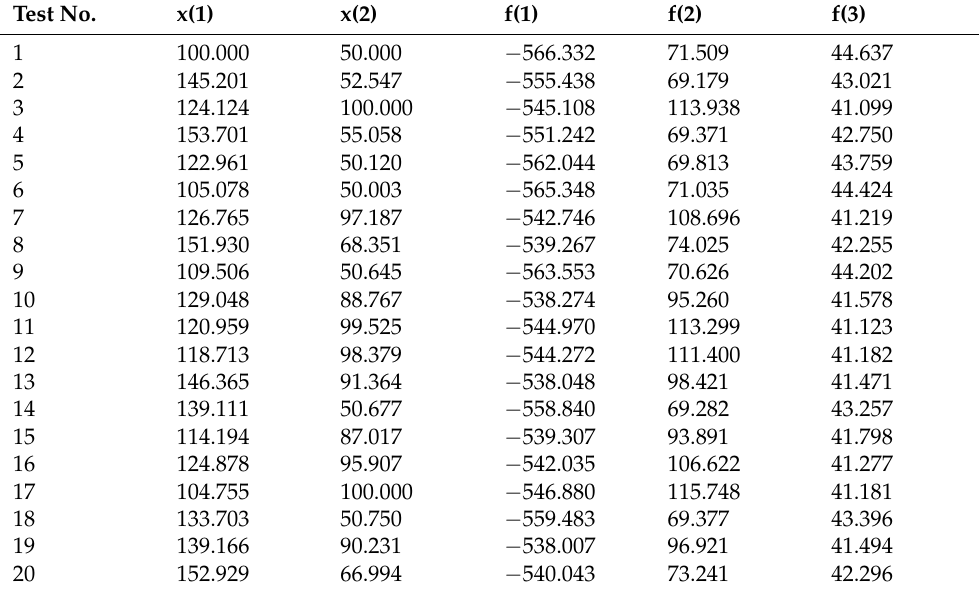
Table 5. Partial Pareto optimal solution for multi-objective optimization of powdering quality via DEM